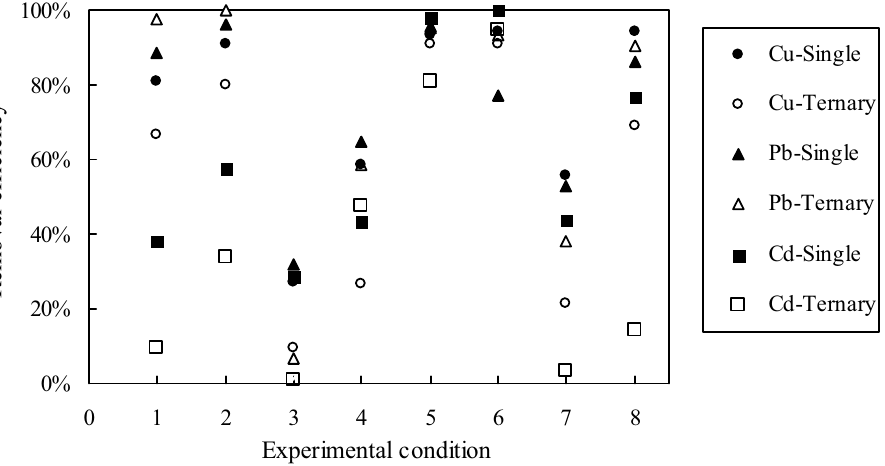
Figure 6. Cu 2+ , Pb 2+ and Cd 2+ removal efficiency from single and ternary metal solutions, Experimental condition (pH, C 0 , D ): 1-(− 1, − 1, − 1), 2-(− 1, − 1, + 1), 3-(− 1, + 1, − 1), 4-(− 1, + 1, + 1), 5-(+ 1, − 1, − 1), 6-(+ 1, − 1, + 1), 7-(+ 1, + 1, − 1), 8-(+ 1, + 1, +